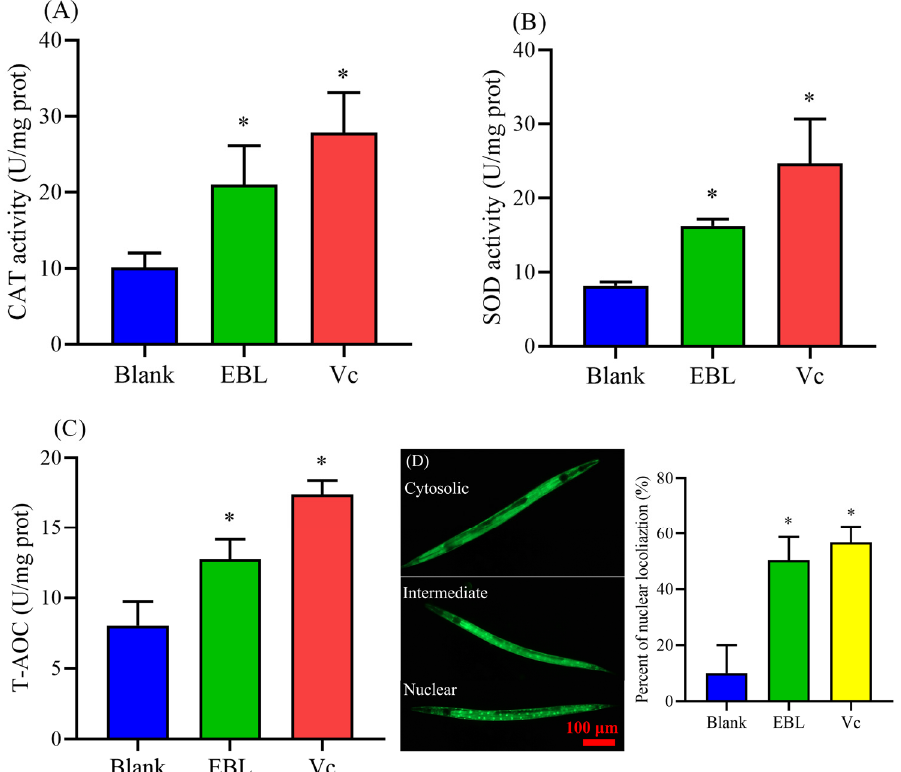
Figure 3. The effect of EBL on the activities of antioxidant enzymes ( A ) CAT and ( B ) SOD, and the ( C ) total antioxidant capacity (T-AOC) in C. elegans under thermal stress. ( D ) After treatment with EBL for 48 h, the DAF-16 transcription factor was localized to the nucleus in C. elegans . The concentration of EBL was 0.1 mg/mL. Vc meant ascorbic acid (10 µ g/mL). Note: * meant p < 0.05.